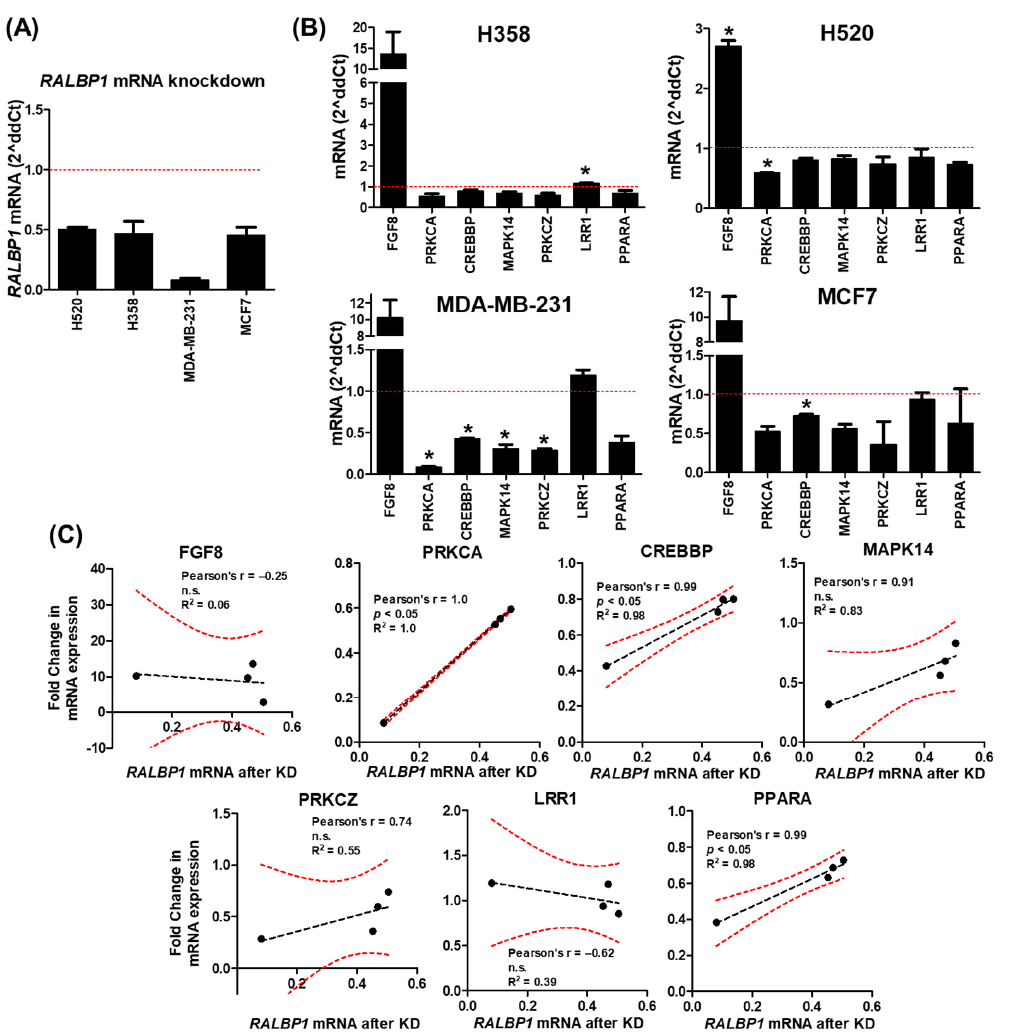
Figure 1. Rlip knockdown regulates oncogene transcription. H358 and H520 lung cancer cells and MDA-MB-231 and MCF7 breast cancer cells were collected 24 h following transfection with a RALBP1 -targeted locked nucleic acid (Rlip-LNA), which induces RNAse H-mediated mRNA degradation. ( A ) RALBP1 mRNA knockdown at 24 h following Rlip-LNA transfection. ( B ) Target mRNA expression following Rlip knockdown was evaluated relative to scrambled controls, which were defined as 1 and are indicated by the red dotted lines. ( C ) For PRKCA , CREBBP , and PPARA , the degree of expression change significantly correlated with the observed level of RALBP1 mRNA knockdown (plotted as the fraction of RALBP1 mRNA remaining after knockdown (KD)), supporting a causal relationship between Rlip knockdown and transcriptional regulation. In ( B ), asterisks (*) indicate p < 0.05 by Student’s t -test when comparing mRNA expression from each Rlip-LNA treatment to its corresponding scrambled control treatment. Error bars indicate SEM ( n =